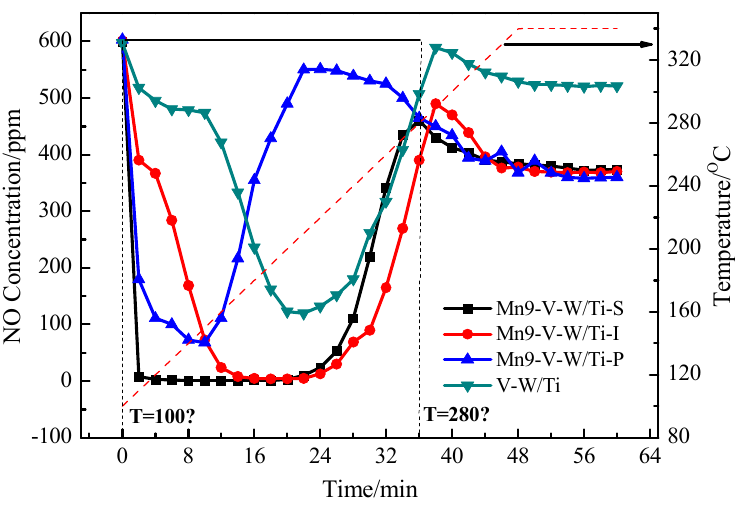
Figure 9. Temperature programmed surface reaction (TPSR) profiles of the catalysts at a space velocity of 10,500 h − 1 . Reaction conditions: [NO] = [NH 3 ] = 600 ppm, [O 2 ] = 3 vol.%, N 2 as the balance gas, total flow rate = 350 mL · min − 1 .